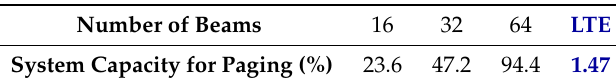
Table 1. Capacity analysis for directional paging [10].